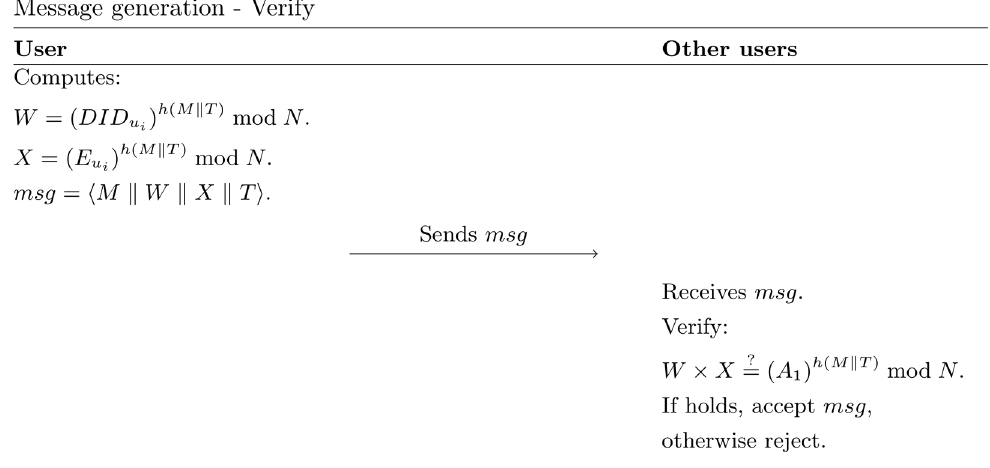
Fig 4. Message generation—Verify phase in